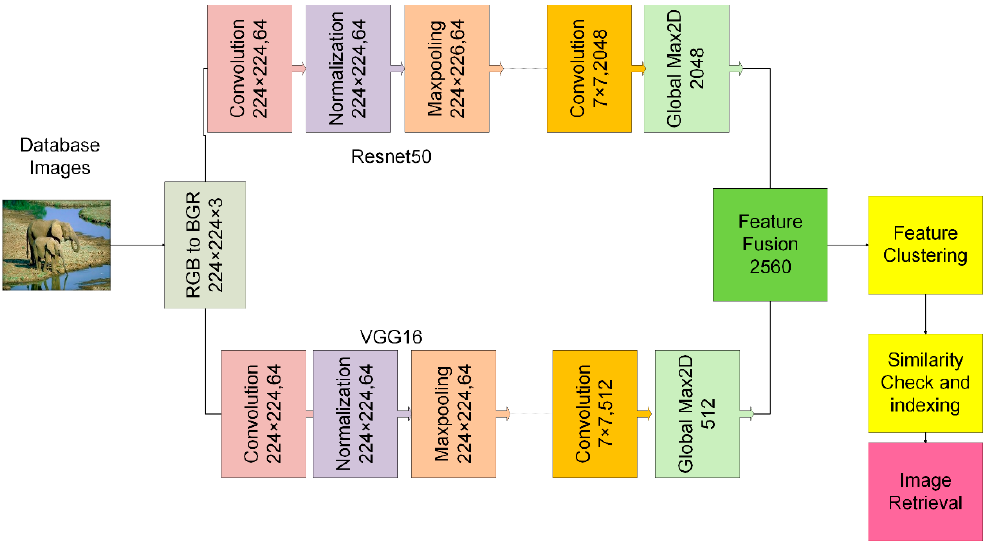
Figure 1. The proposed CBIR. Table 2. Parameters of the network’s layers.